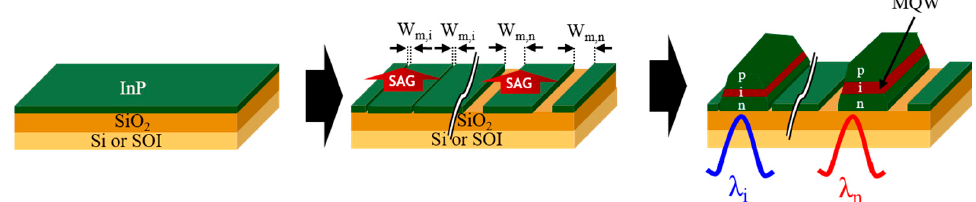
Figure 7. Description of the specific SAG process developed on InP-SOI and InPoSi wafers